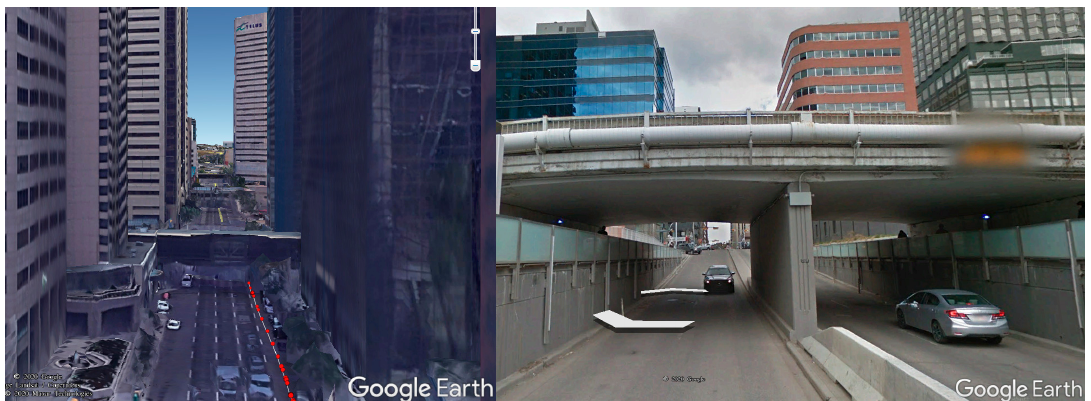
Figure 4. Google Earth view of field test 2.